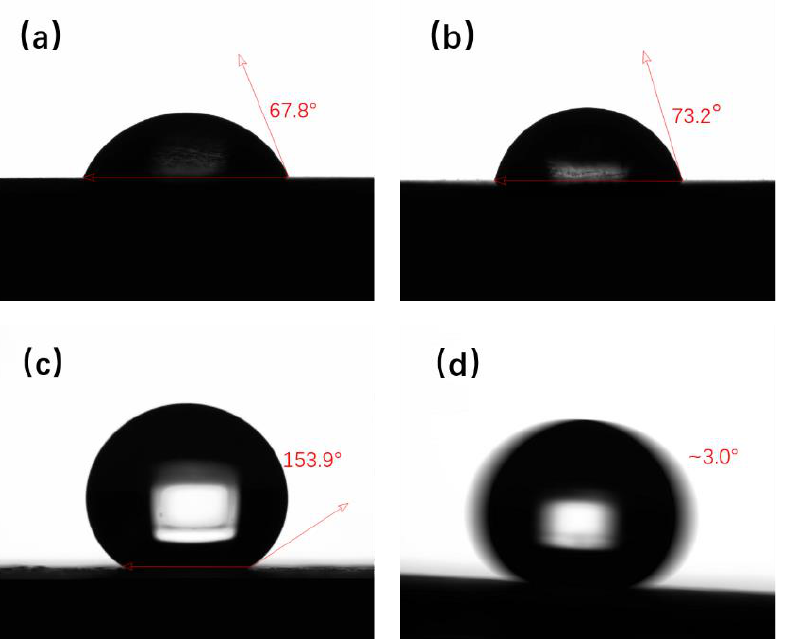
Figure 4. ( a ) CA of Q235 steel before grinding, ( b ) CA of Q235 steel after grinding by 500# sandpaper, ( c ) CA of superhydrophobic coating surface, and ( d ) SA of superhydrophobic coating surface.